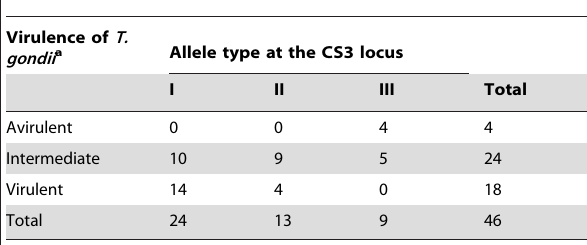
Table 3. Association between mouse virulence and the allele type at the CS3 locus of Toxoplasma gondii isolates obtained from animals and humans in Minas Gerais.